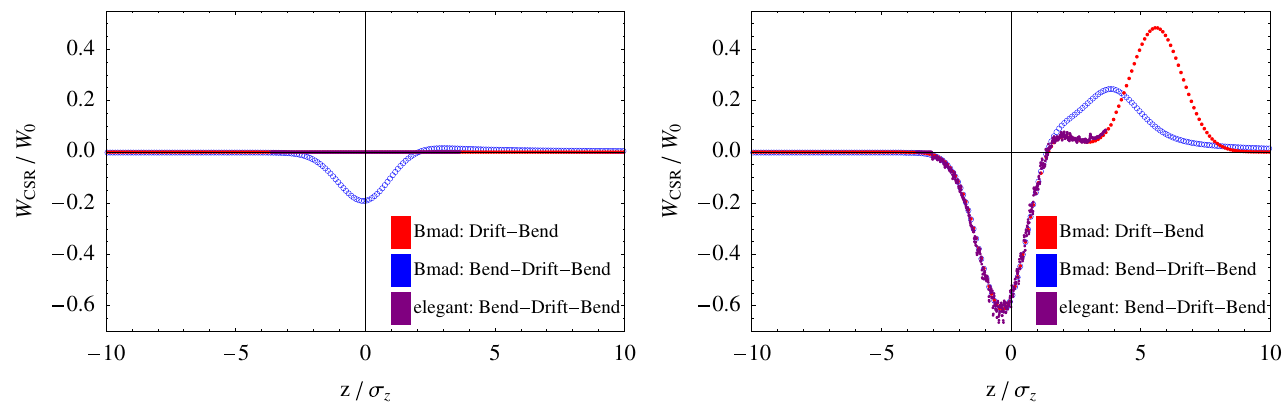
FIG. 17. (Color) The wake in the second bend of a bend-drift-bend configuration as calculated by Bmad and ELEGANT . For reference, a third curve has been added that shows the wake, as calculated from Bmad, for a drift-bend configuration. The parameters from set B of Table I and with a 1 m drift between the bends was used. Top: The wake after 1 cm into the bend. Bottom: The wake after 100 cm into the